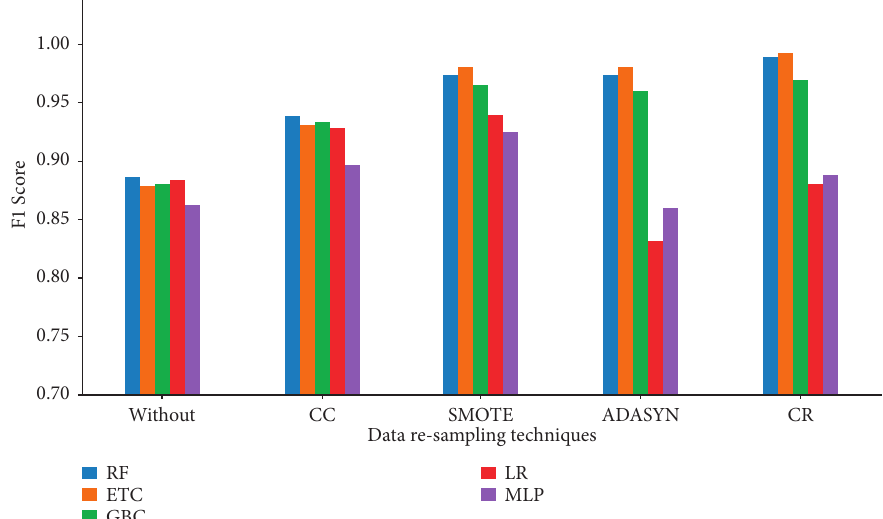
Figure 3: Comparison of F1 score for all